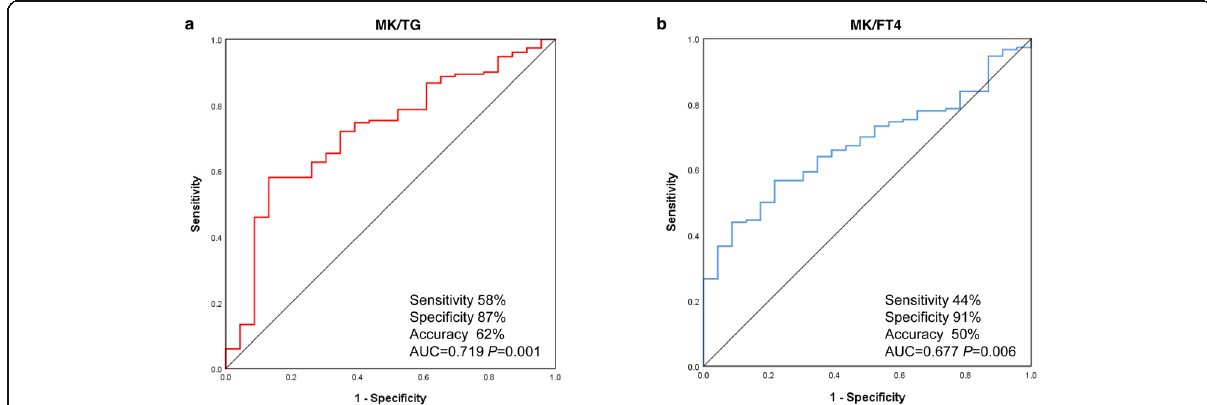
Fig. 3 Diagnostic value of midkine (MK)/thyroglobulin (TG) and MK/free thyroxine (FT4) ratios for papillary thyroid carcinoma (PTC). Receiver operating characteristic curves were drawn to assess the diagnostic utility of the ( a ) MK/TG ratio and the ( b ) MK/FT4 ratio in preoperatively distinguishing PTCs from benign thyroid nodules. The areas under the curve (AUC) for the MK/TG and MK/FT4 ratios were 0.719 ( P = 0.001) and 0.677 ( P = 0.006), respectively, with no significant difference ( P = 0.896). The cut-off values of MK/TG and MK/FT4 were 55.57 ng/mg (sensitivity 58%, specificity 87%, accuracy 62%) and 0.11 μ g/pmol (sensitivity 44%, specificity 91%, accuracy 50%),